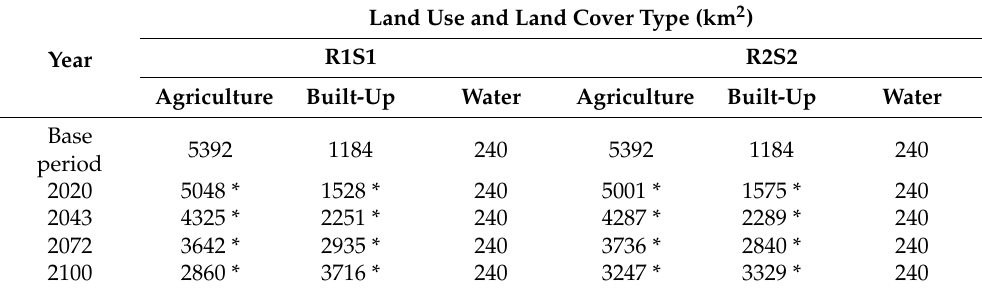
Figure 3. Future projections of three dominant land use and land cover types under R1S1 and R2S2 scenarios using Map-1. Table 3. Area under three broad land use and land cover types for the NF, MF and FF, projected under R1S1 and R2S2 scenarios.